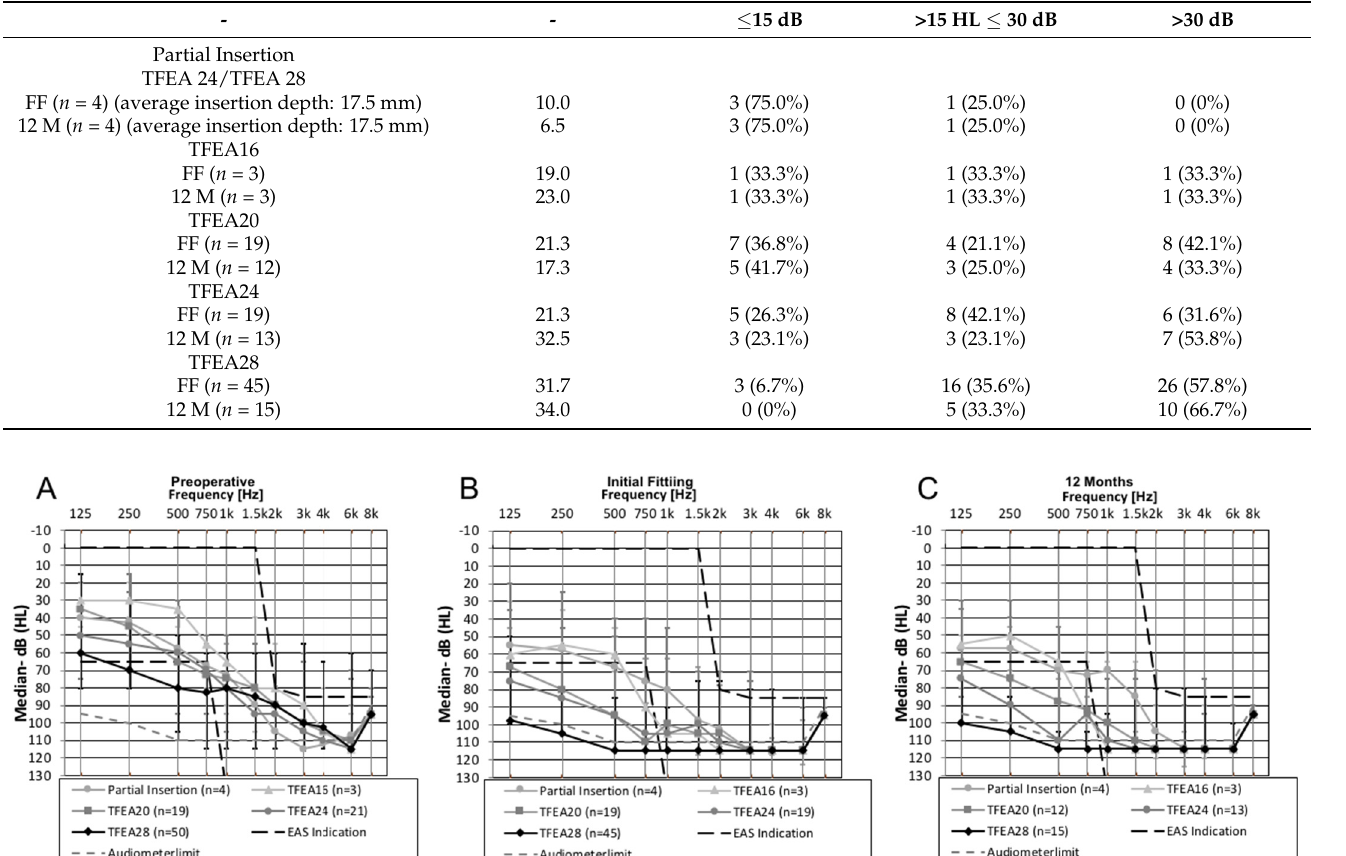
Table 2. Postoperative hearing loss (HL) with different partial inserted electrode arrays and full inserted electrode arrays at the time of the first fitting (FF) and 12-months (12 M).